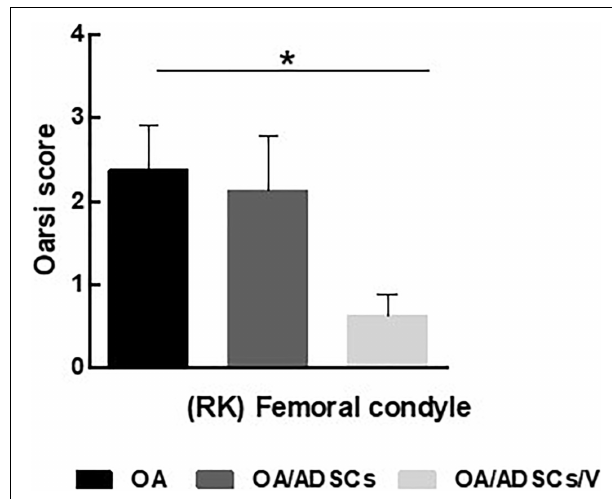
FIGURE 5 | OARSI score grading for histologic alteration in OA, OA/ADSCs, and OA/ADSCs/Col V. * P < 0 .